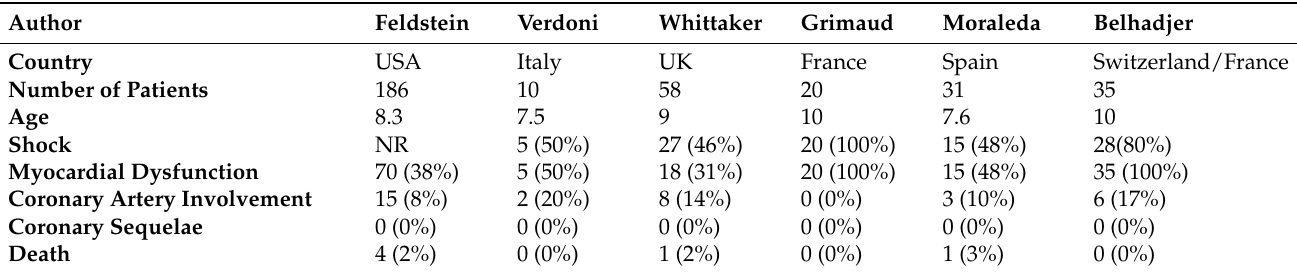
Table 3. Comparative view of the most important published papers regarding MIS-C and cardiac complications